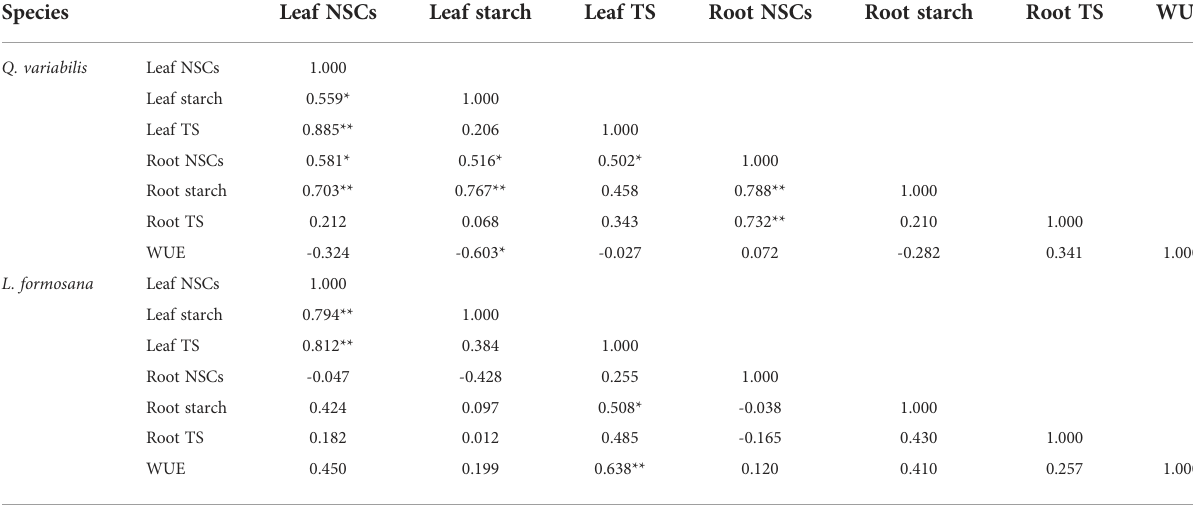
TABLE 3 Correlation coef fi cients of long-term WUE and NSC values for Q. variabilis and L. formosana .